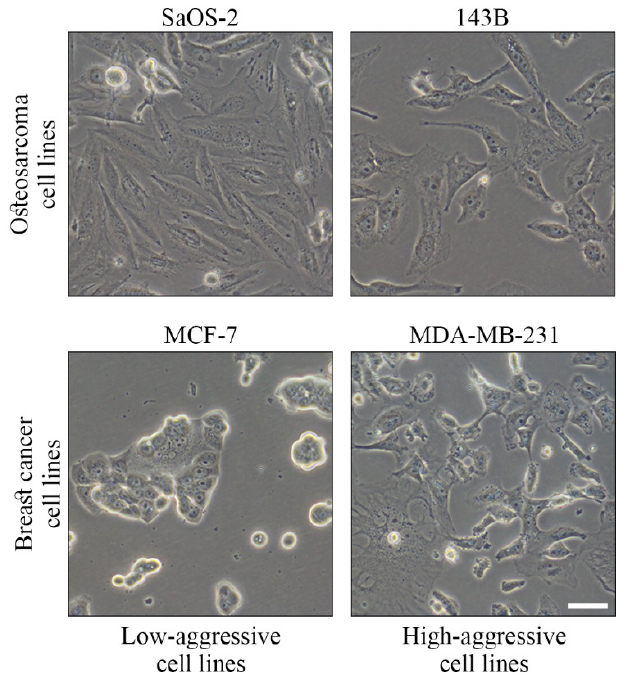
Figure 3. Representative images (40X) of the cancer cell lines on the day of the experiment, 24 h after plating in a 60 mm Petri dish. Bar, 100 µm.